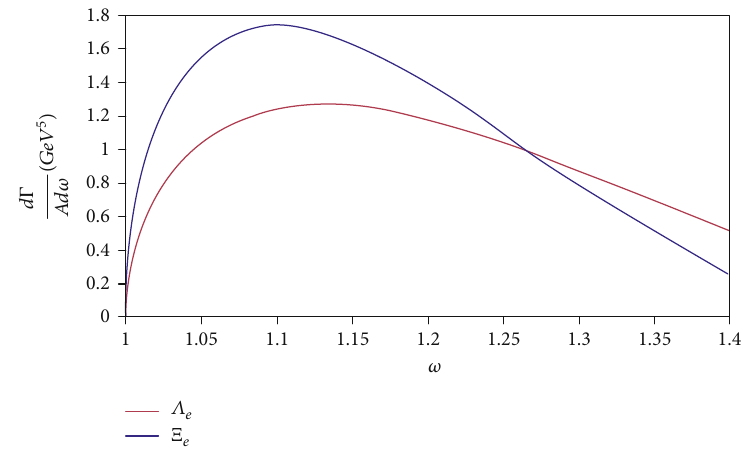
Figure 4: Di ff erential decay width for b